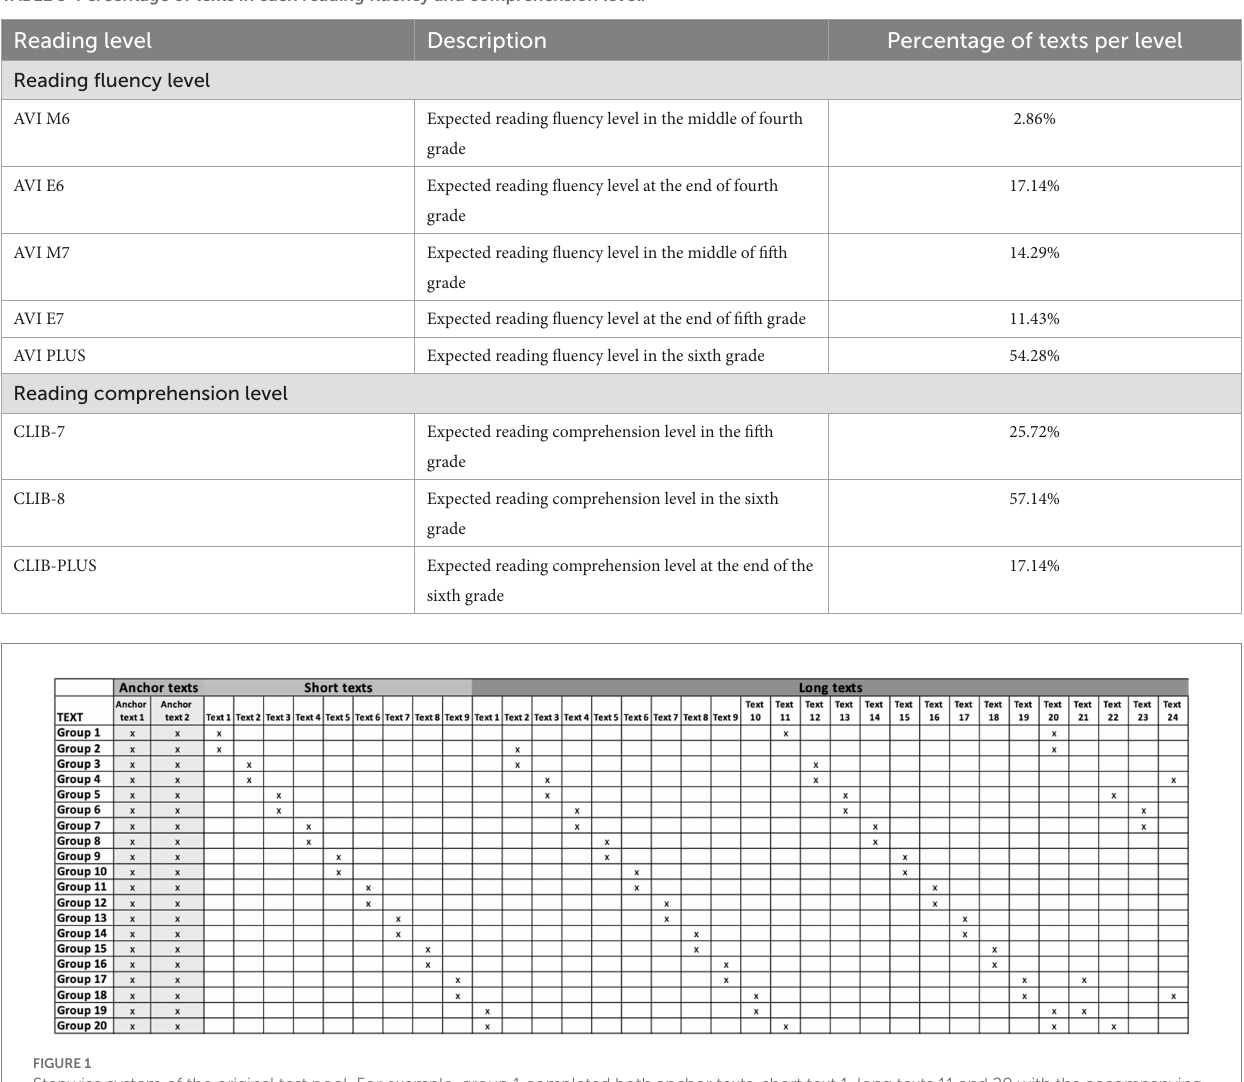
TABLE 3 Percentage of texts in each reading fluency and comprehension level.